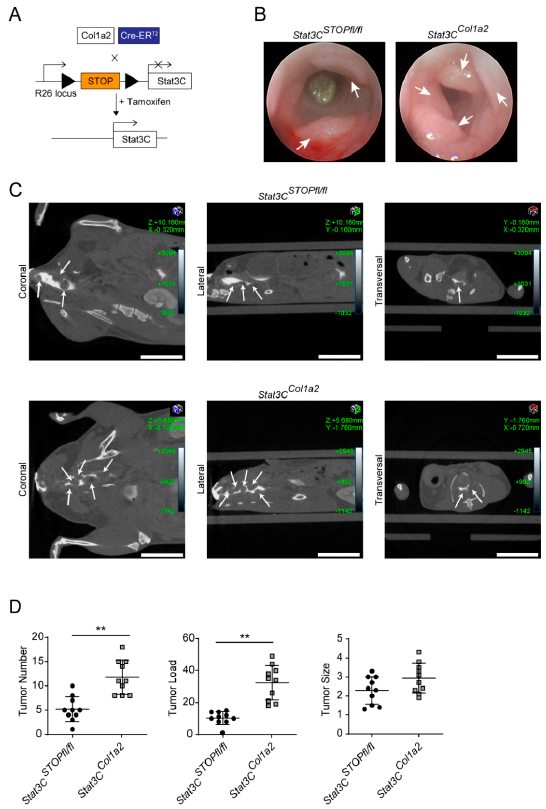
Figure 2. Constitutive activation of STAT3 in type I collagen-expressing fibroblasts promotes the development of CRC in the AOM/DSS model. ( A ) Scheme of the genetic strategy for the expression of a constitutively active STAT3 (STAT3C) protein in COL1+ cells by cross-breeding of Col1a2-CreER T2 with R26Stat3C STOPfl/fl mice. Triangles show loxP sites. ( B ) Tumor development in the AOM/DSS model was monitored in Stat3C Col1a2 mice and littermate controls by mini-endoscopy at day 62. ( C ) Tumor development in the AOM/DSS model was analyzed in Stat3C Col1a2 mice and littermate controls by contrast-agent-enhanced micro-CT and shown in coronal, sagittal and axial planes. Arrows indicate colon tumors. Scale bar: 10 mm. ( D ) Tumor number, tumor load and tumor size (mm) of AOM/DSS-treated Stat3C STOPfl/fl ( n = 10) and Stat3C Col1a2 mice ( n = 10) were quantified ex vivo at day 64. The results are representative of at least two independent experiments. Quantitative data are shown as mean values ± SD. Significant differences are indicated (** p < 0.01).